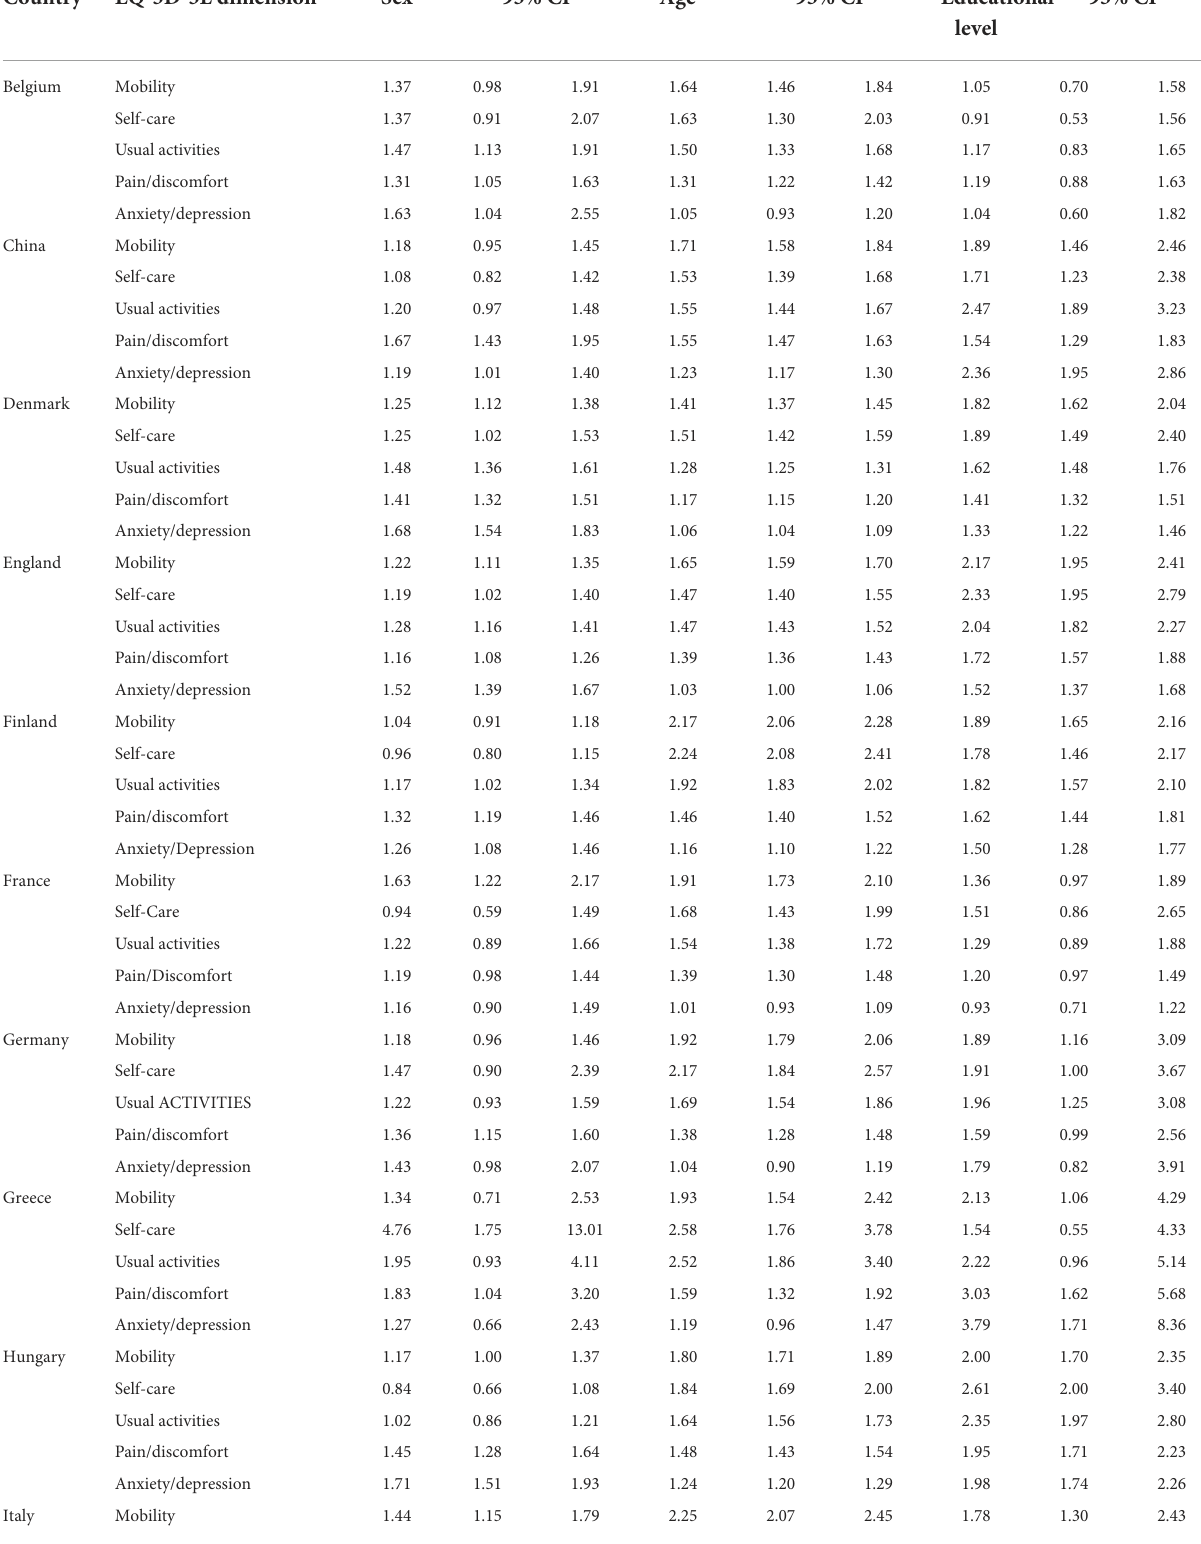
TABLE 3 Odds ratios (95% confidence intervals) for reporting any problems on EQ-5D-3L dimensions in 18 countries.